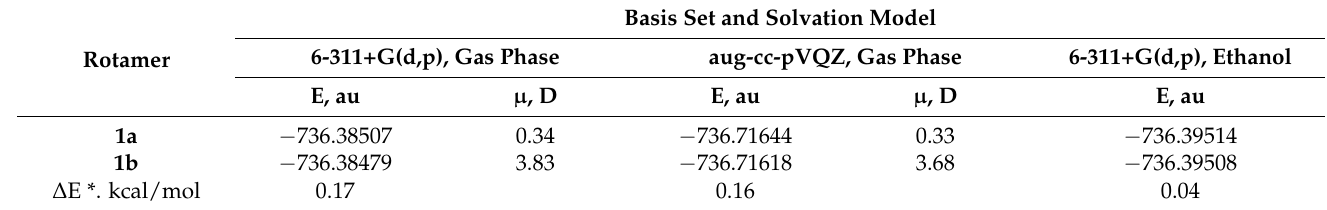
Table 3. Selected geometrical parameters of most preferable rotamer 3-(5-phenyl-2 H -tetrazol-2- yl)pyridine 1a obtained by X-ray analysis and calculated by DFT B3LYP method at different basis sets in the gas phase and ethanol (IEFPCM model).